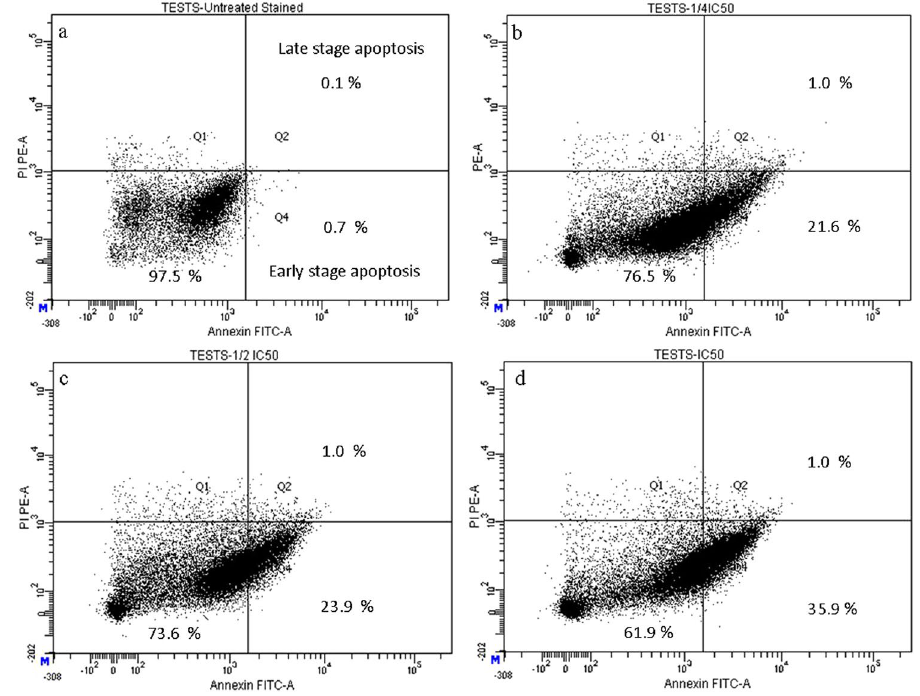
Figure 7. Annexin V/PI assay showing the apoptosis-inducing effect of CPT-CEF. HT29 cells were treated with various concentrations of CPT-CEF: ¼ IC 50 (panel b), ½IC 50 (panel c), IC 50 (panel d), or untreated (panel a) for 48 h, and viability was assessed via Annexin V/PI assay and flow